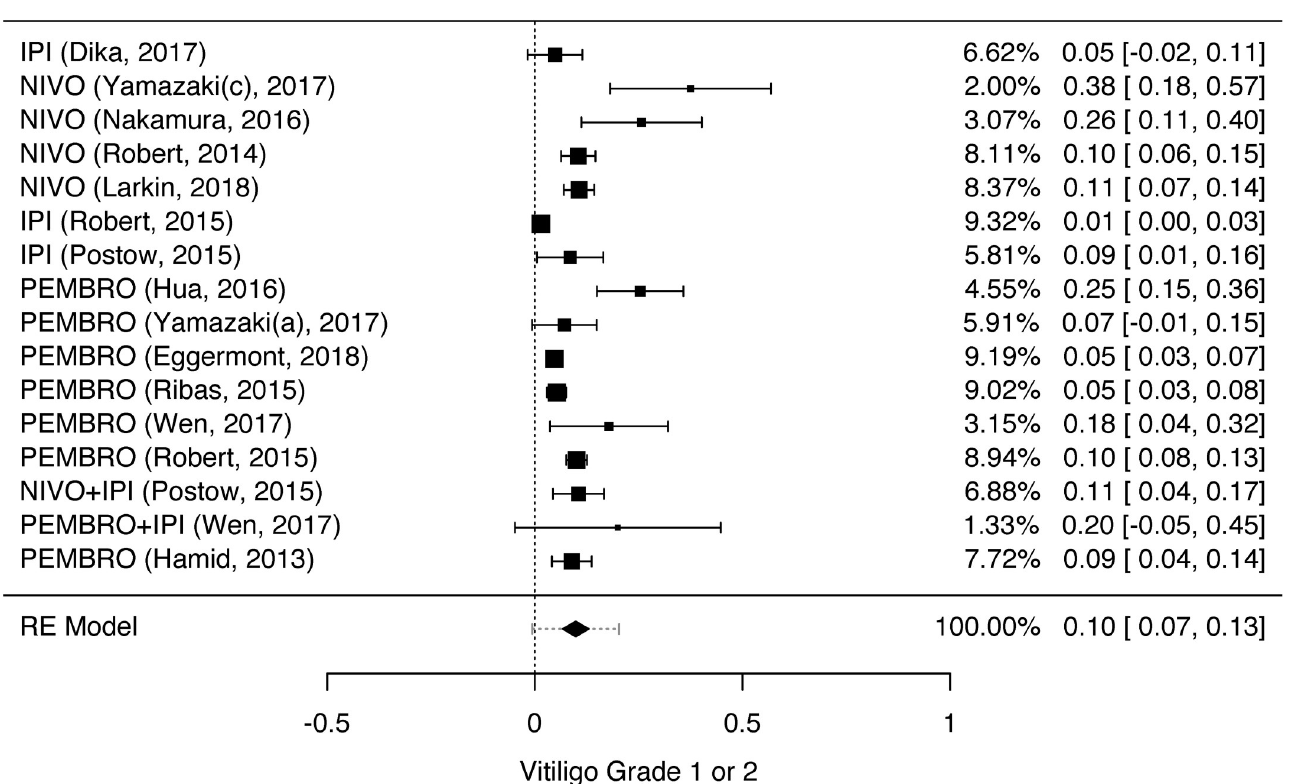
Fig 4. Meta-analysis of vitiligo outcome grade 1 or 2. Elaborated by the authors using JAMOVI 1 . Legend: IPI—Ipilimumab, NIVO—Nivolumab, PEMBRO— Pembrolizumab.